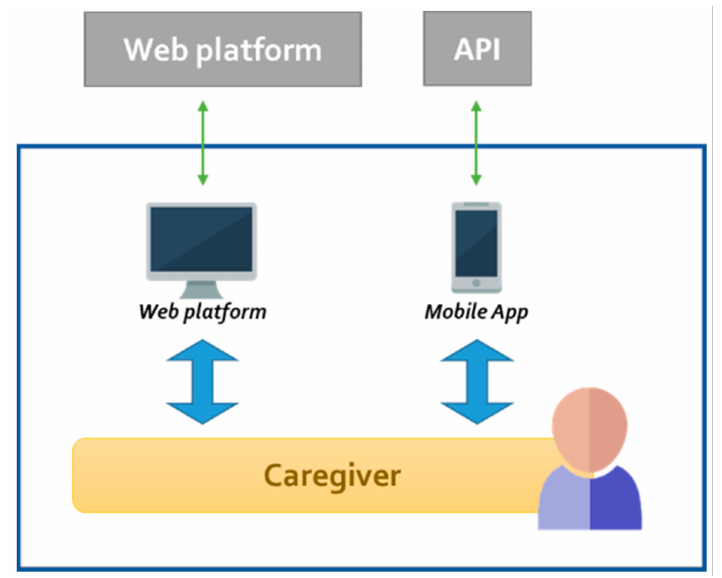
Figure 5. Information and alerts module.